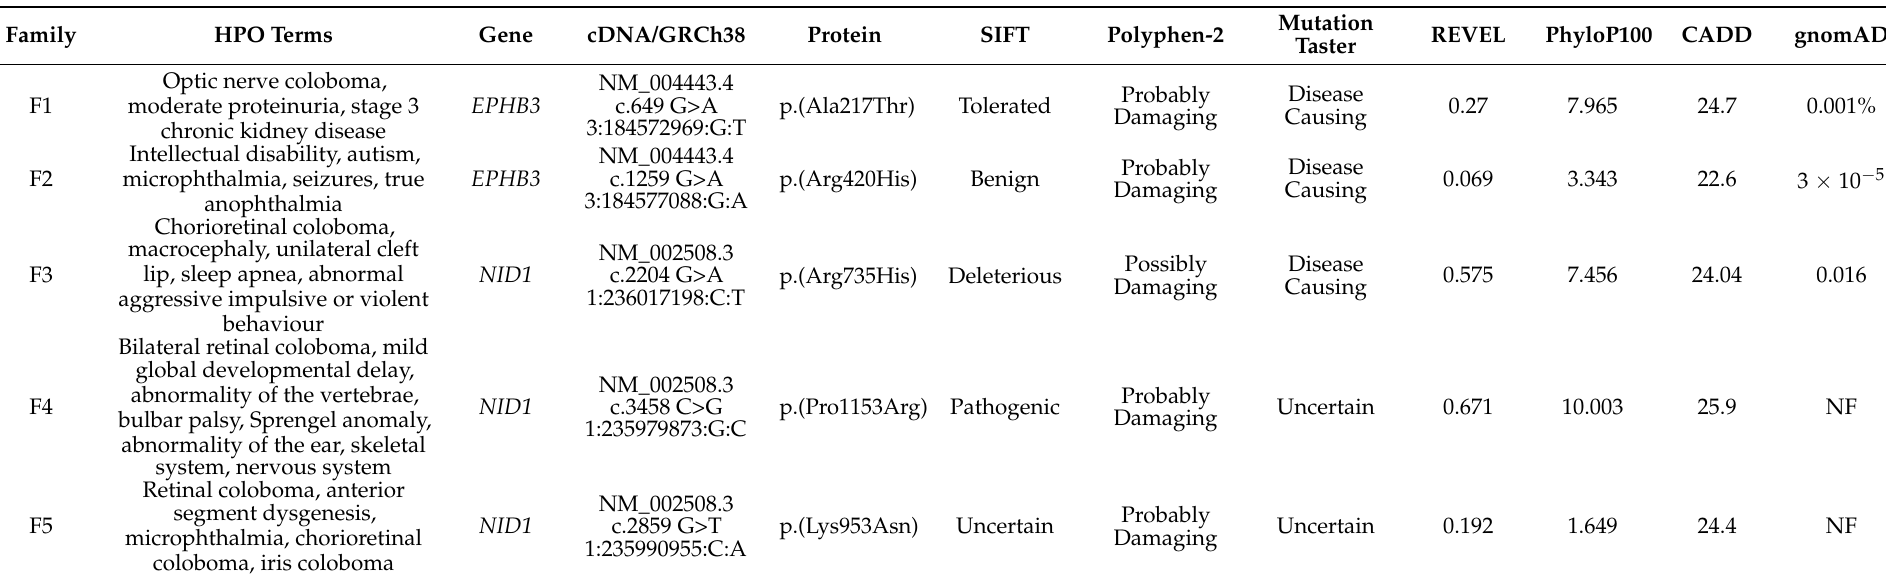
Table 3. Summary of in silico analysis of single nucleotide variants (SNVs) identified. Screening of probands enrolled in the 100,000 Genomes Project presenting with HPO terms including microphthalmia, anophthalmia, or coloboma for in silico predicted damaging variants resulted in five families. The cDNA position of the SNV, the subsequent amino acid change, and the genomic location for the human reference genome GRCh38 are presented. All the variants identified were heterozygous. Outcomes of the predictive algorithms SIFT, Polyphen-2 and MutationTaster, REVEL, and UCSC PhyloP100 are reported, with respective scaled CADD scores and allele frequency as reported in gnomAD (https://gnomad.broadinstitute.org, accessed on 1 October 2022, NF—not found). For NID1, no Dandy-Walker phenotypes were identified in the HPO terms for these